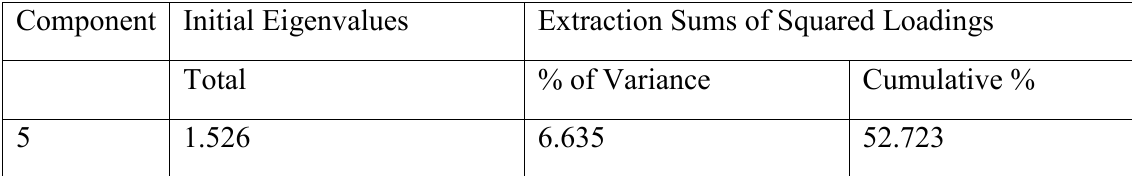
Table 1.47: Variance explained for Transformative Resilience PC5